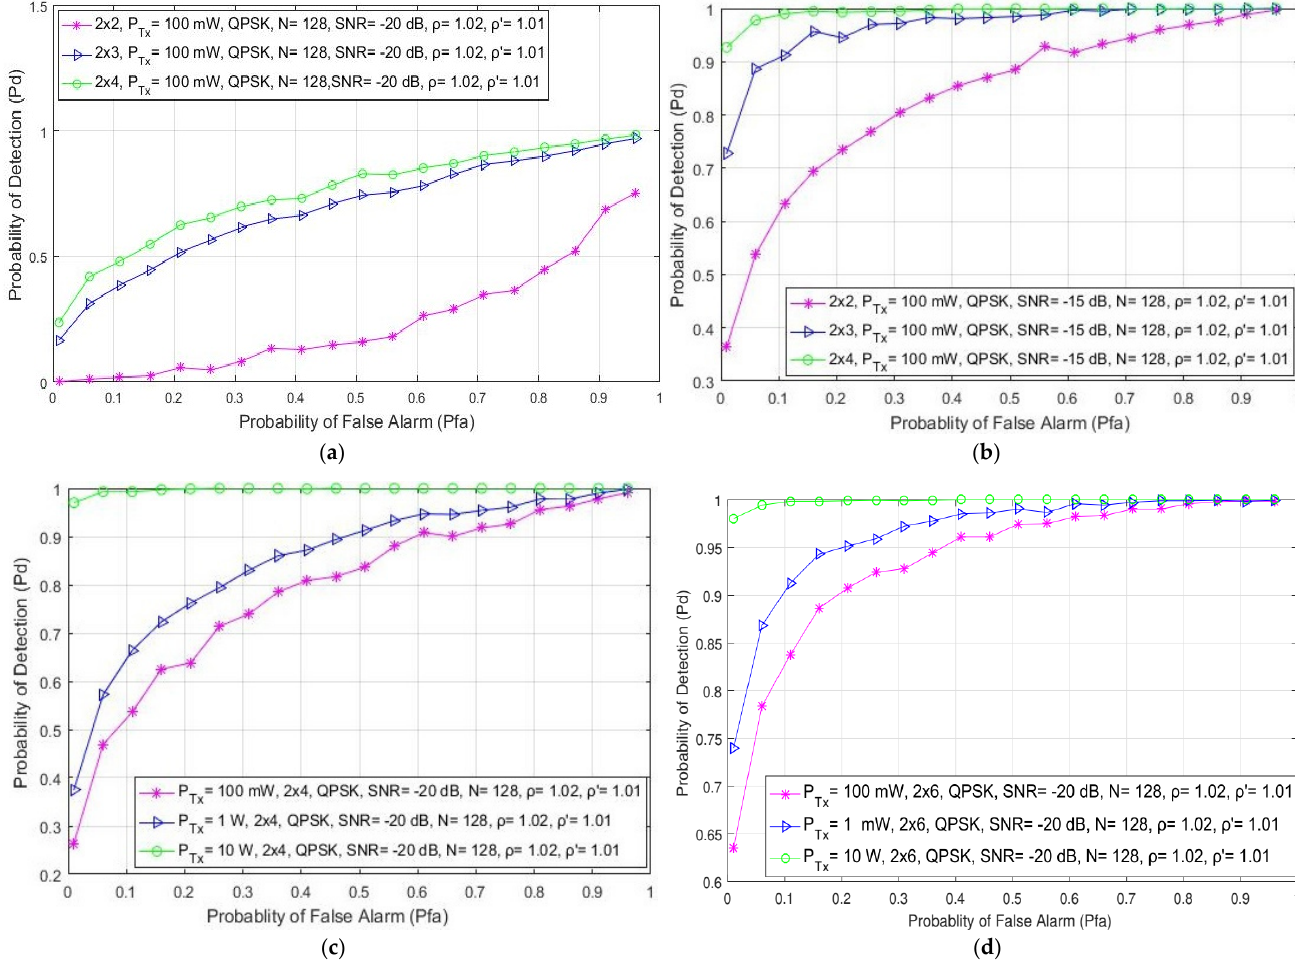
Figure 4. The ROC curves presenting the ED performance for the different PU Tx powers and the SNR of − 20 dB in ( a ) SISO, ( b ) 2 × 2, ( c ) 2 × 4 and ( d ) 2 × 6 MIMO communication systems.